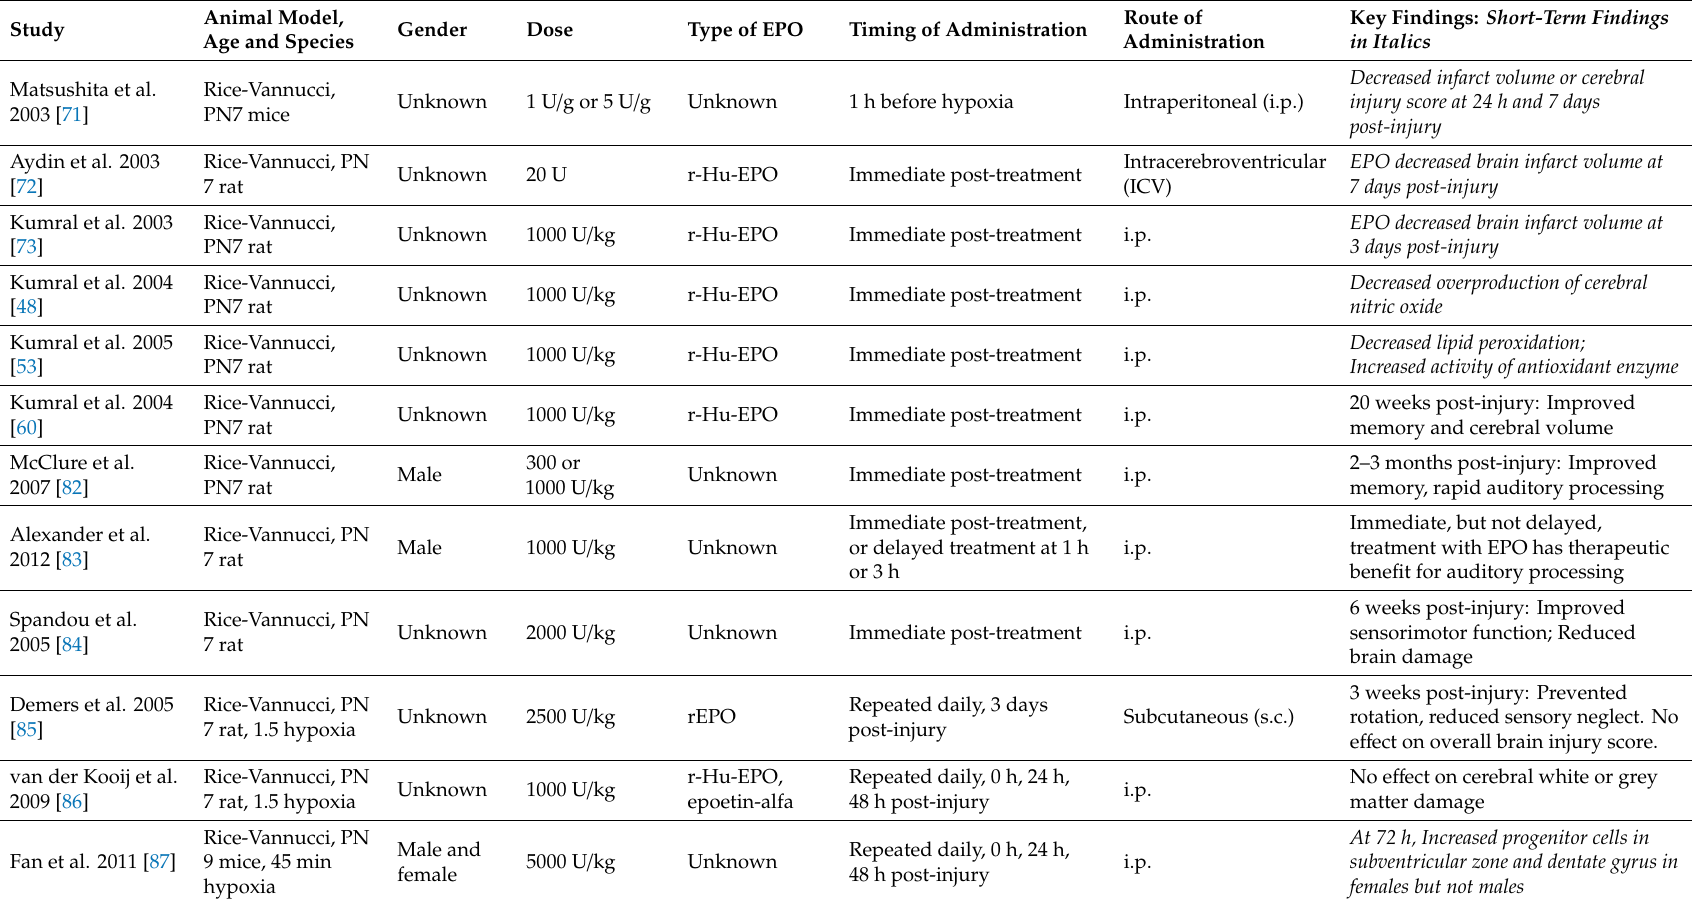
Table 1. Animal studies on neonatal hypoxia-ischemia or neonatal stroke: E ff ect of EPO